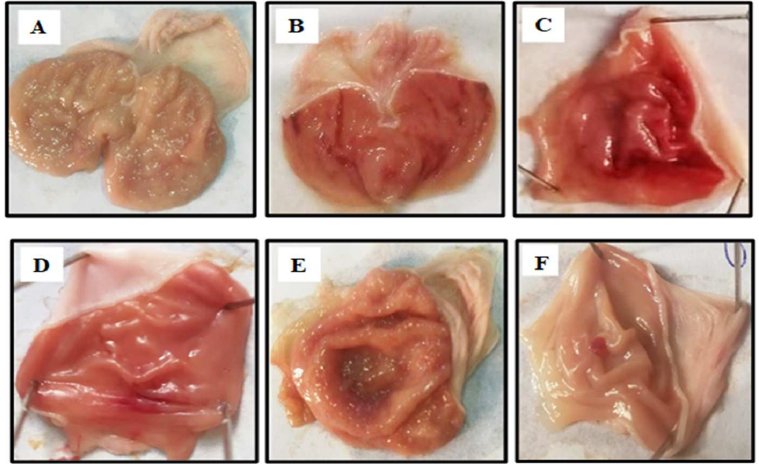
Figure 4. Gross appearance of gastric mucosa in rats: ( A ) treated with saline 10 mL/kg. ( B )